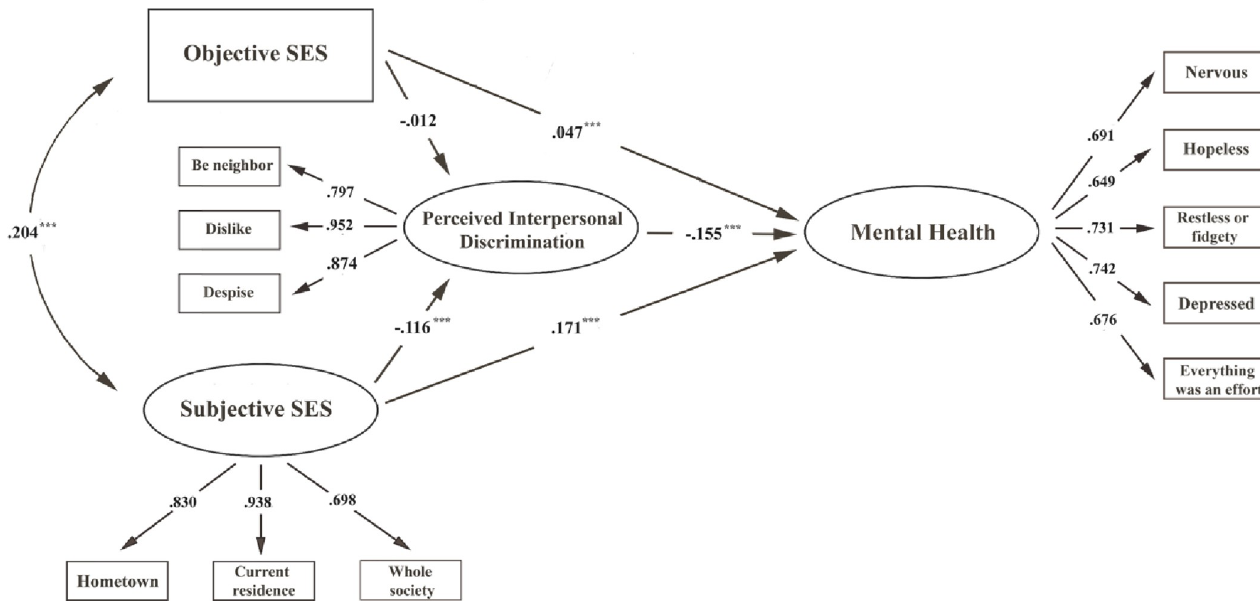
Fig 2. Association between socioeconomic status and mental health among Chinese migrants (structural equation model). Note. Standardized factor loadings and path coefficients are shown; ��� p < 0.001. Model fits: GFI = .987, AGFI = .979, CFI = .949, RMSEA = .028, and SRMR = 0.018.